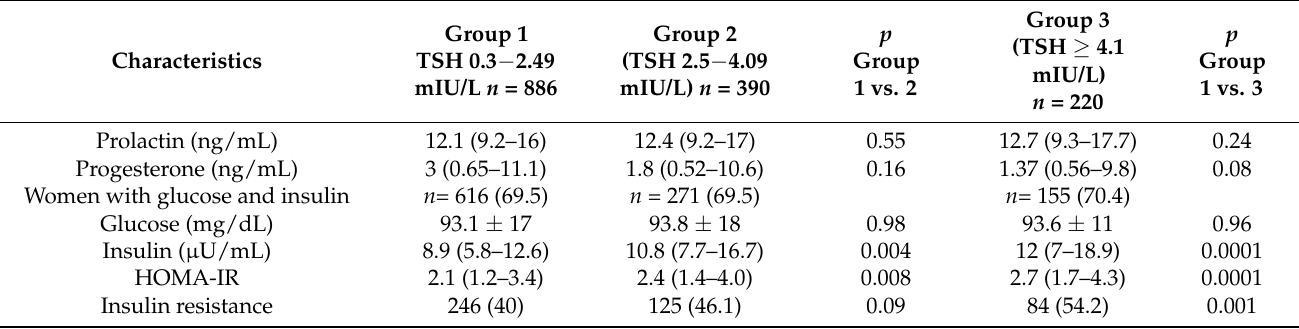
Table 3. Biochemical characteristics of infertile Mexican women with and without subclinical hypothyroidism using two cut-offs for